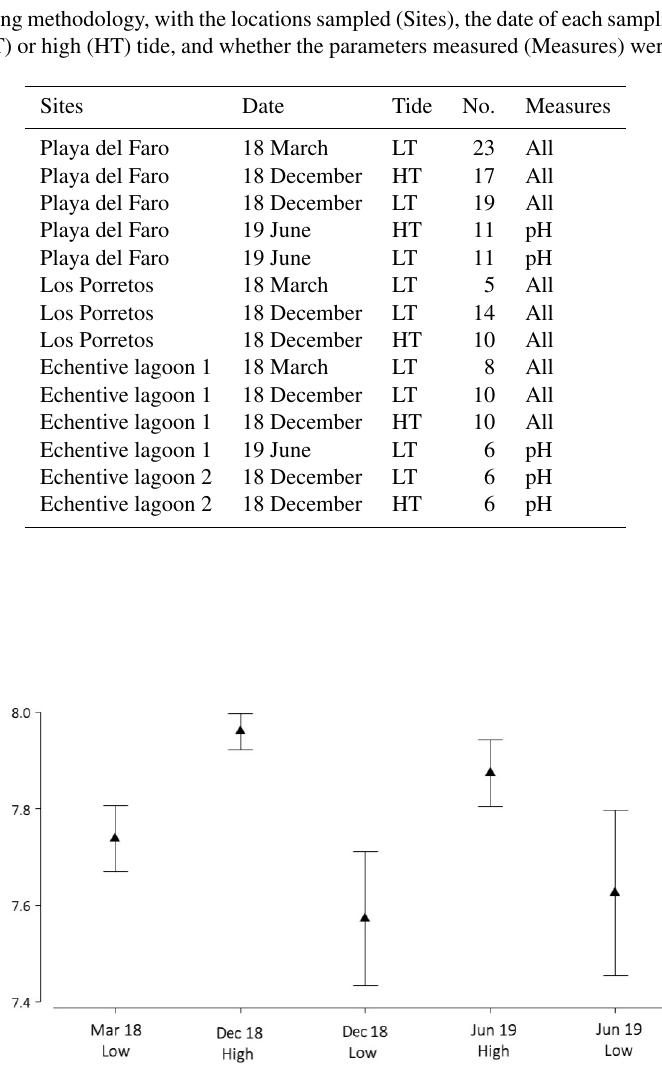
Figure B1. Graph representing the tidal fluctuation (low and high tide) of the mean pH with standard deviation (SD) at Playa del Faro,